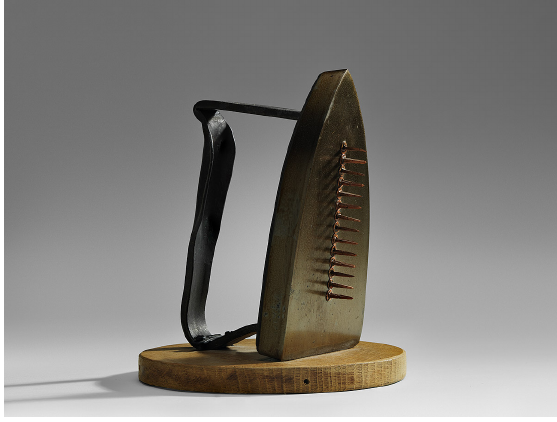
Figure 1. Man Ray. Cadeau